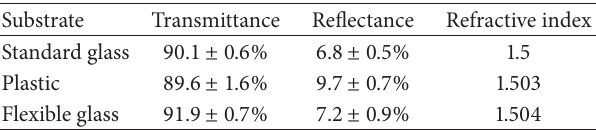
Table 2: The comparison of transmittance and reflectance of three